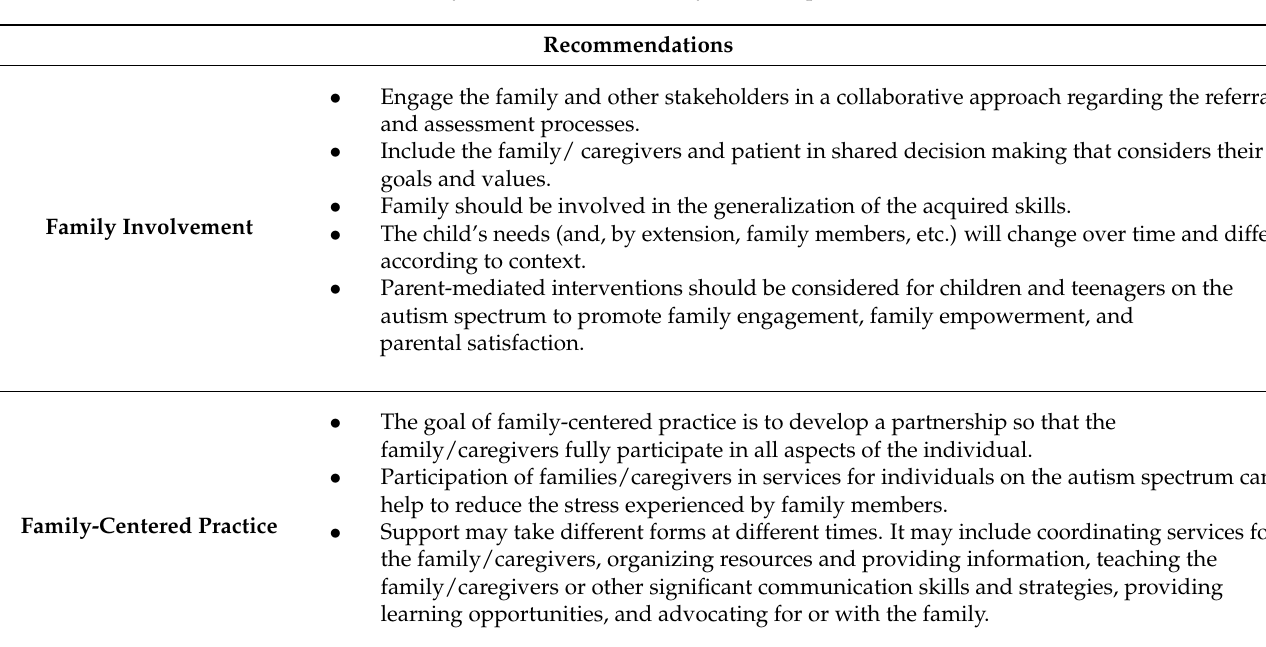
Table 5. Family involvement and family-centered